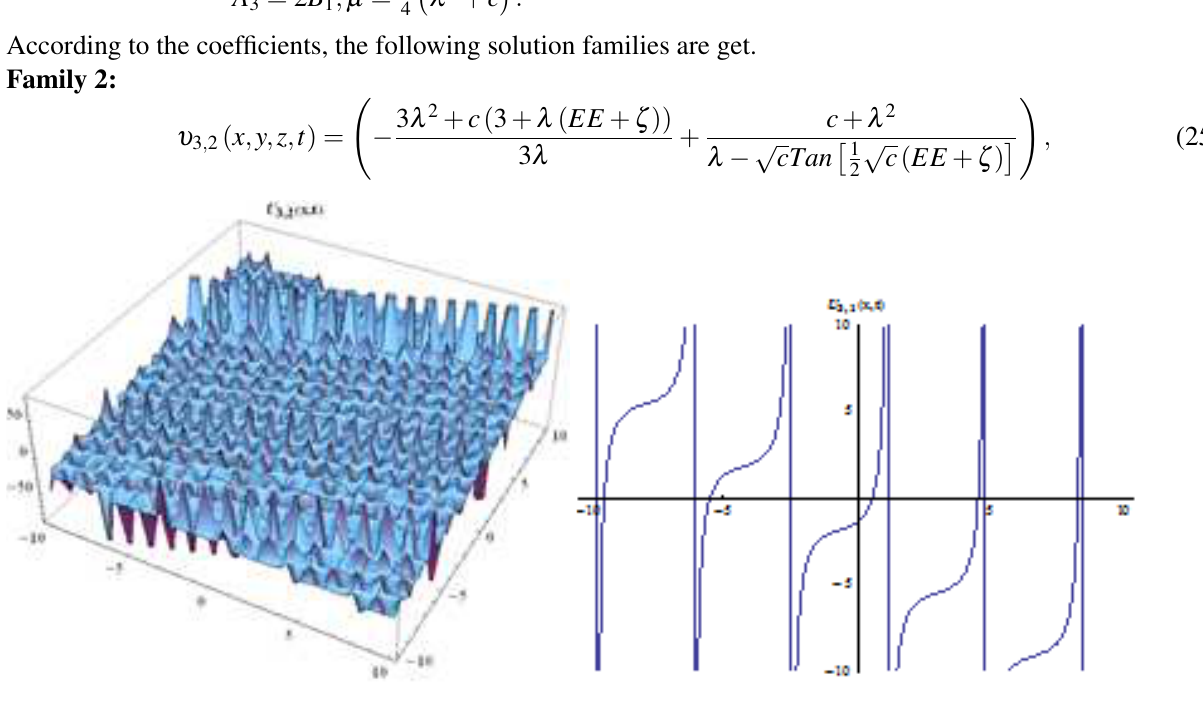
Figure 7: The 3D and t = 1for 2D of